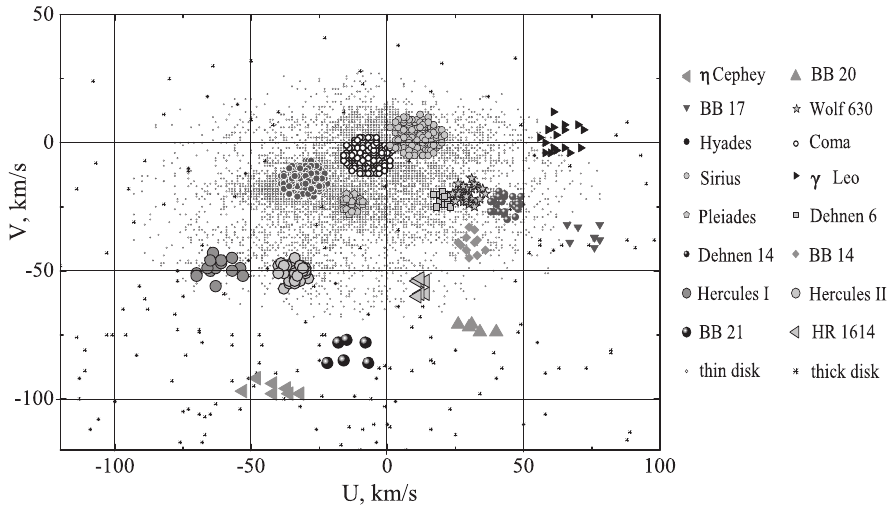
Fig. 1. UV -diagram for stars from the catalog of Casagrande et al. (2011). Different symbols mark stars of the selected streams; the legend is shown on the right side of the figure. The streams with (cid:104) V (cid:105) less than ≈ − 50 km s − 1 are indicated by larger symbols. The abbreviation “BB” represents the streams found by Bobylev & Bajkova